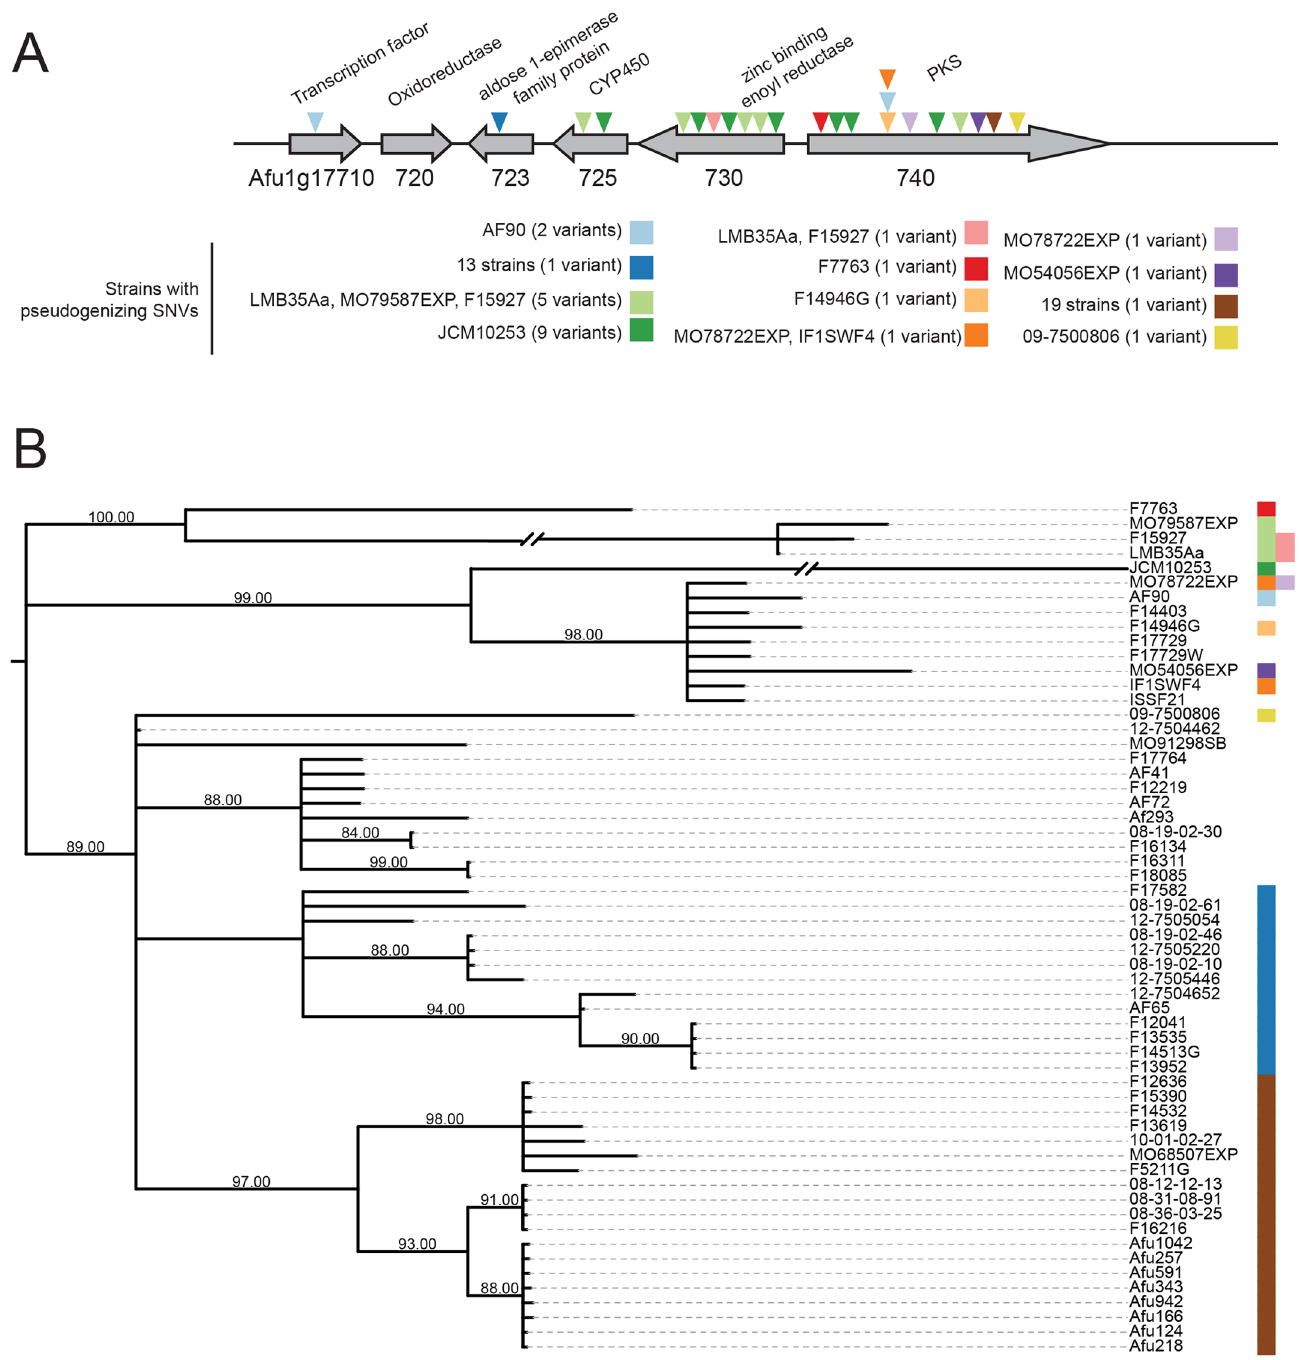
Fig 3. Pseudogenization in the fusarielin-like SM gene cluster. (A) Positions of frameshift variants and nonsensevariants in the fusarielin-like SM gene cluster 4. (B) Locus phylogeny of the fusarielin-like SM gene cluster based on a nucleotide alignment of the entire gene cluster, including intergenicand noncoding regions. The phylogeny is midpoint rooted and branches with bootstrapsupport < 80% are collapsed. Two branches were shortenedfor visualizationpurposes. Strains with pseudogenizingvariants are indicatedwith colored boxes. Colors correspond to variants shown in (A). PKS, polyketidesynthase; SM, secondary metabolite; SNV, single nucleotide variant.